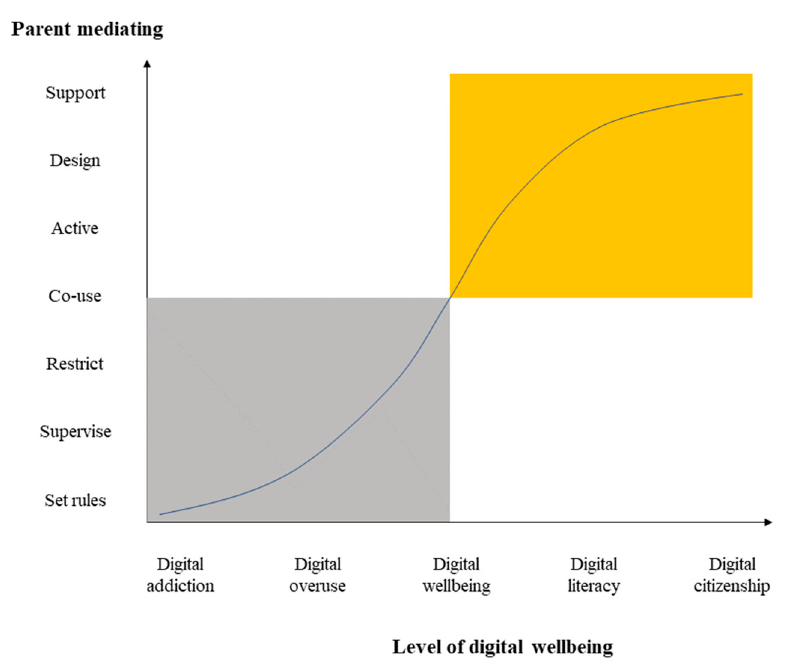
Figure 2. Model of young children’s digital well-being. This model demonstrates the dynamic system of the development of young children’s digital well-being through parental mediation—the curved line across the axis shows the development of young children’s digital well-being. Negative mediating strategies have the effect of contributing to digital addiction and digital overuse among young children (the gray square). In contrast, positive mediating strategies improve young children’s digital literacy and make it possible to develop digital citizenship (the yellow square).